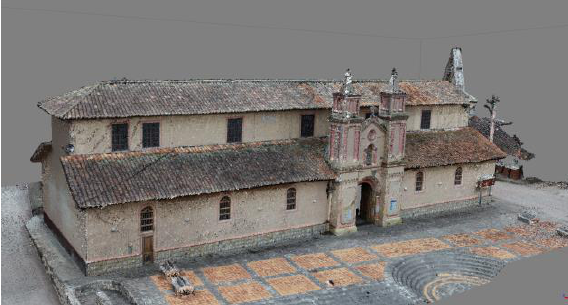
Figure 8 . Nabón’s church dense point cloud